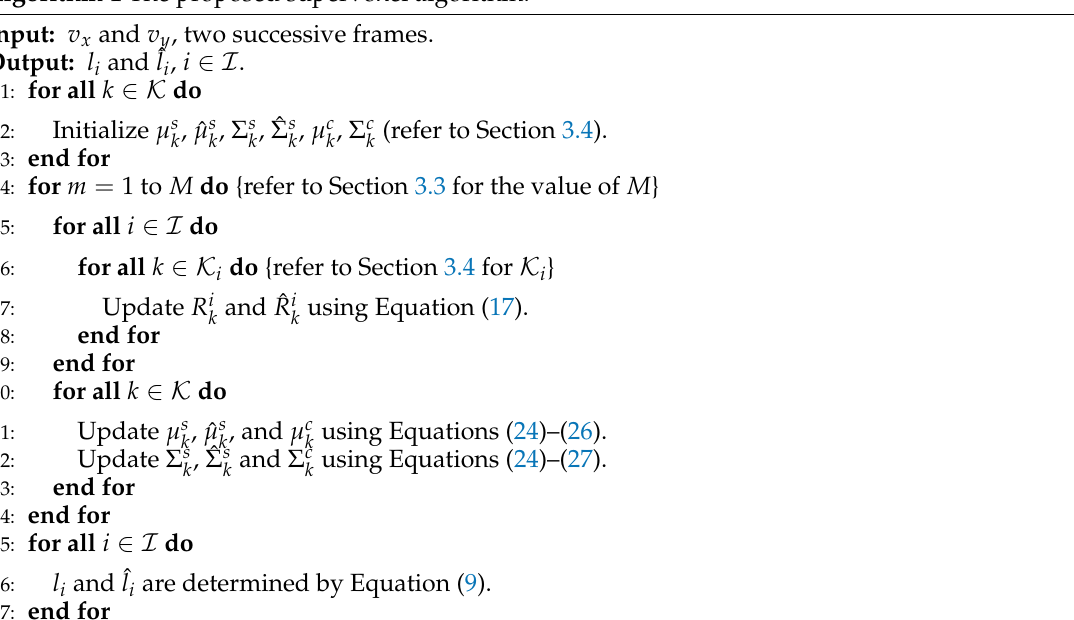
Algorithm 1 The proposed supervoxel